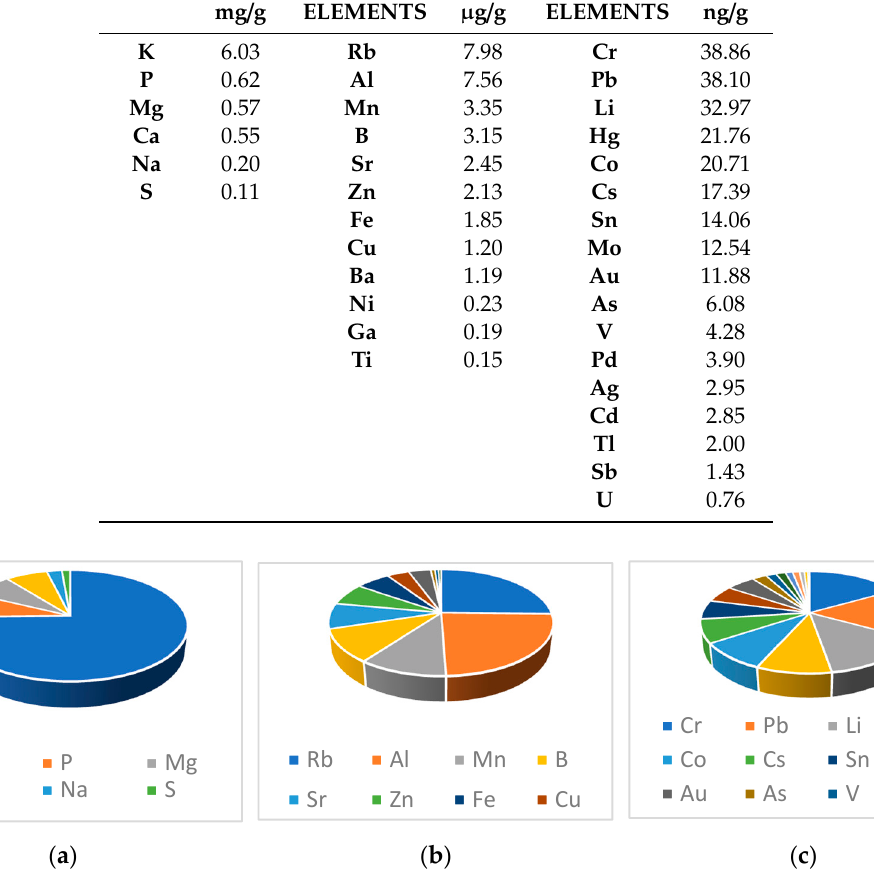
Figure 4. Elements distribution: major elements ( a ), minor elements ( b ) and trace elements ( c ).